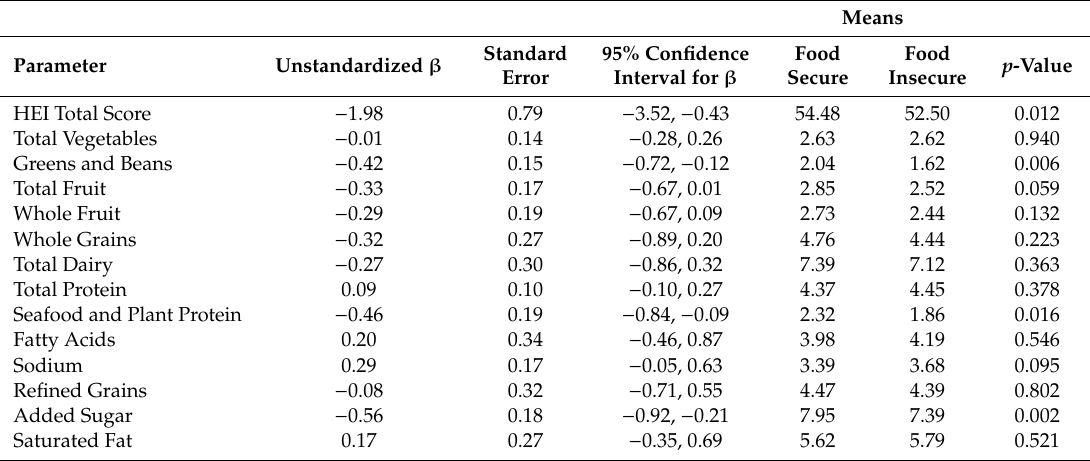
Table 3. Mixed e ff ects linear regression model of food security status and Healthy Eating Index-2015 and component scores a .